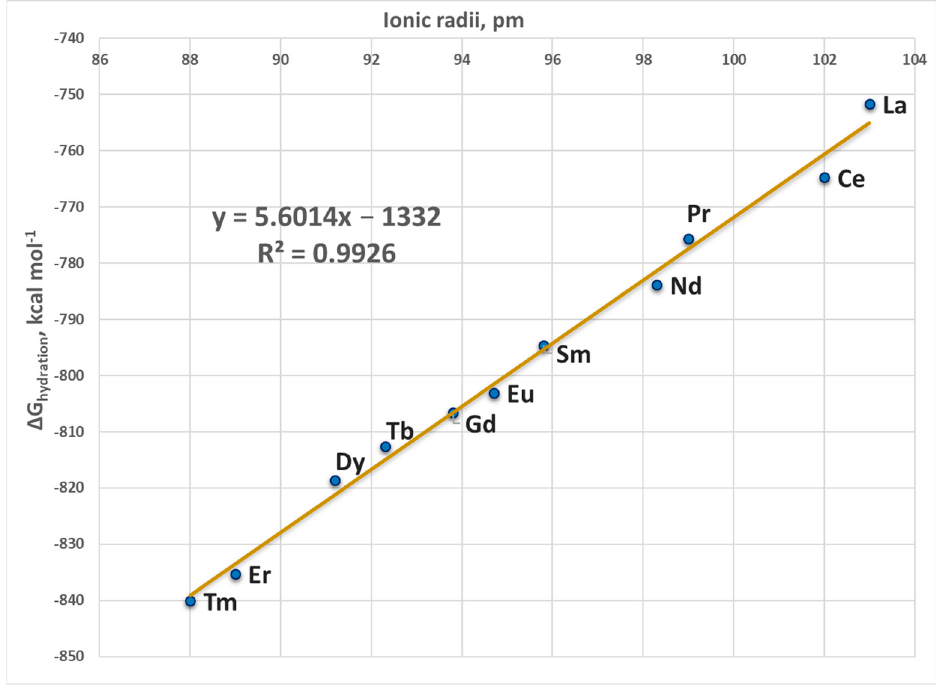
Figure 4. Plot of the experimental Δ G hydration vs. ionic radii for La 3+ /Ln 3+ cations. There are no experimental data for the hydration free energies of Pm 3+ , Ho 3+ , Yb 3+ and Lu 3+ .